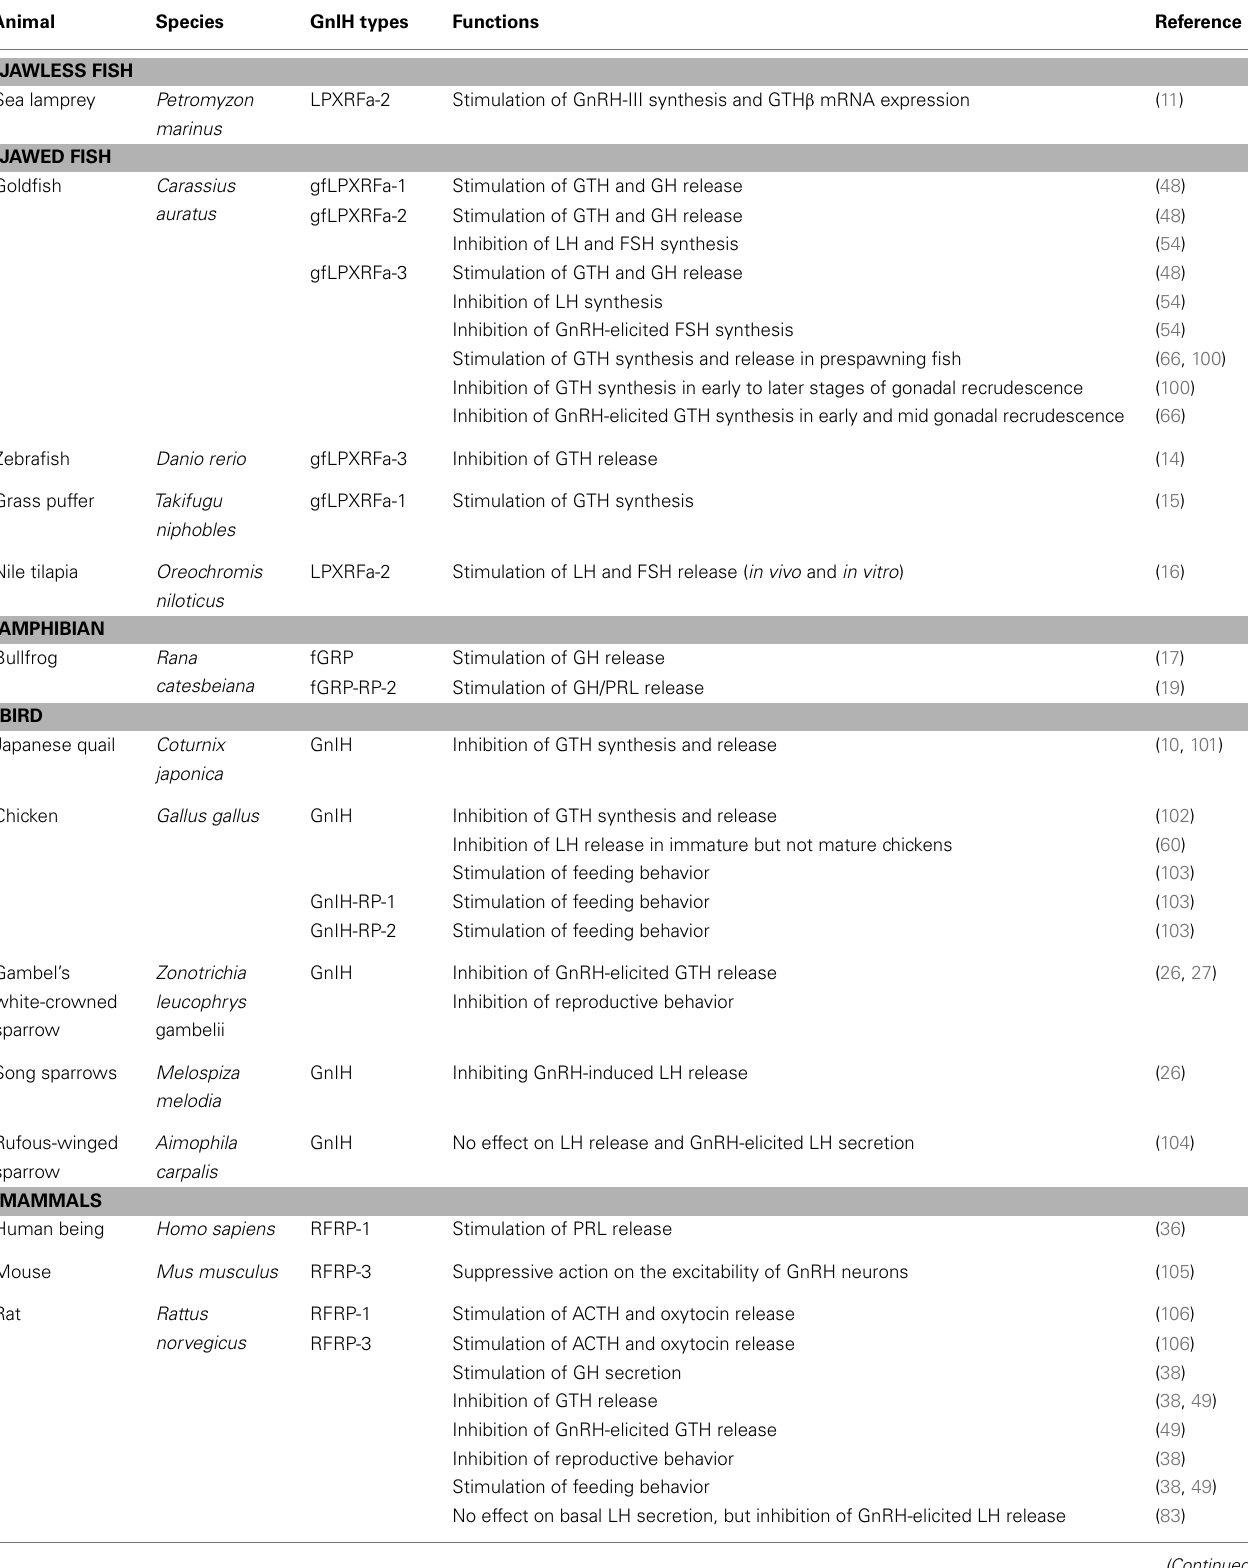
Table 3 | Functions of GnIH and its homologous peptides from jawless fish to mammals